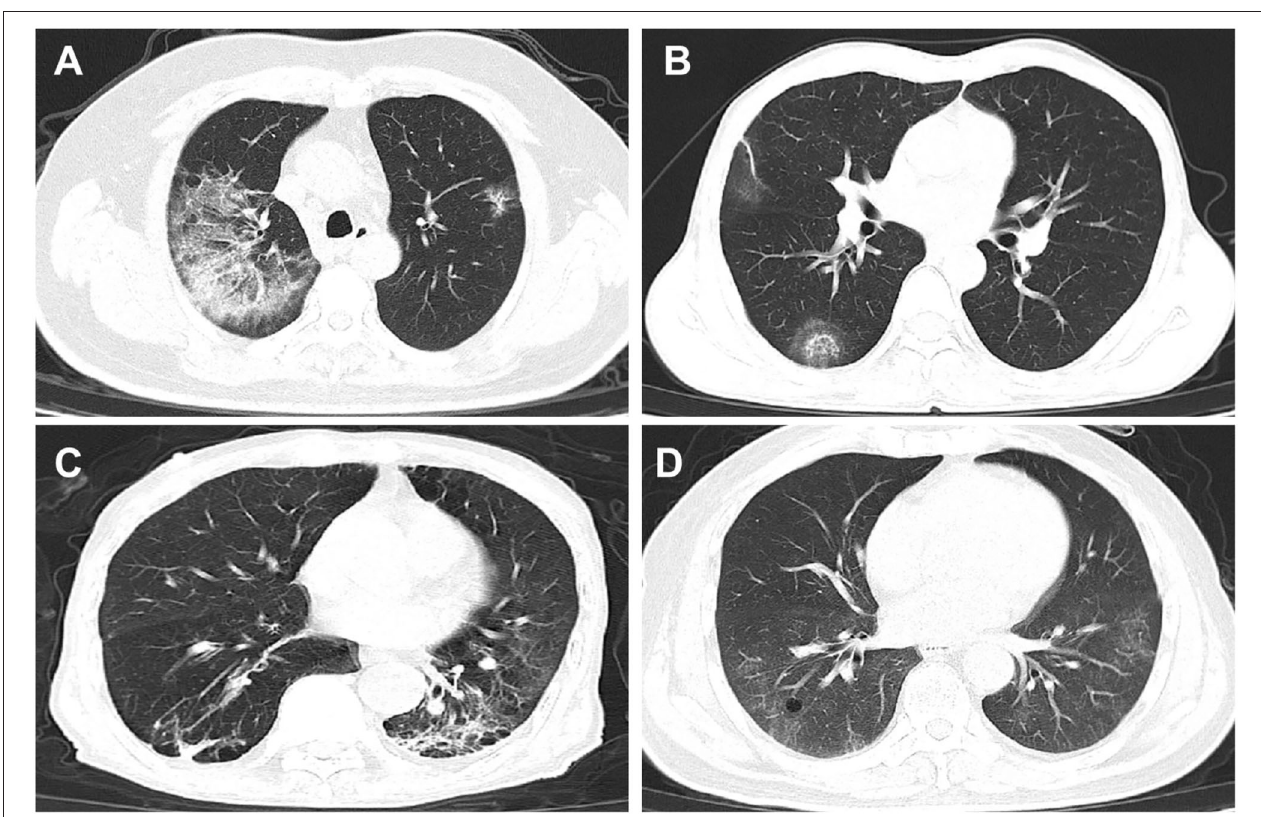
FIGURE 1 | Selected CT graphs of COVID-19 patients infected by the omicron variant of SARS-CoV-2 in Suzhou, China in 2022, taken upon hospital admission, showing representative pathological changes in lungs. (A) From a 64-year-old man with fever and cough symptoms. Axial CT image showed GGOs and consolidation in the right upper lobe, taken on the fifth day from illness onset. (B) From a 53-year-old man having cough and fever. CT image showed rounded opacities in the right lower lobe, taken on the eighth day from illness onset. Lesions were peripherally distributed. (C) From a 61-year-old man with fever. CT image showed linear opacities in the right and left lobes, and lesions were peripherally distributed. Image was taken on the fifth day from illness onset. (D) From a 75-year-old man with cough and fever. Axial CT image showed GGOs and cavitation in the right lobe, and lesion distributions were central and peripheral. Image was taken on the tenth day from illness